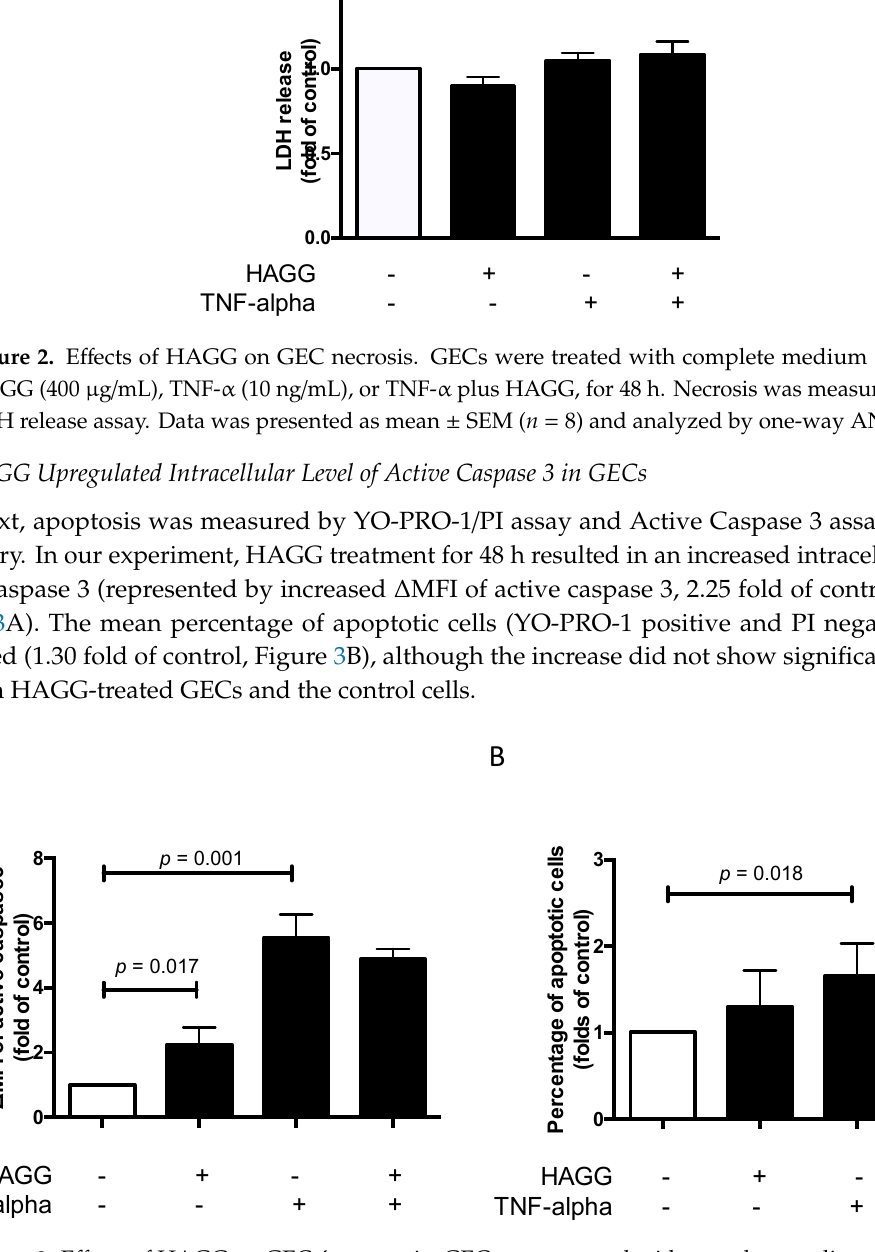
Figure 3. Effects of HAGG on GECs’ apoptosis. GECs were treated with complete medium (control), HAGG (400 µ g / mL), TNF- α (10 ng / mL), or TNF- α plus HAGG for 48 h. ( A ) ∆ MFI of active caspase 3 in GECs ( n = 4). ( B ) Percentages of apoptotic cells measured by YO-PRP-1 / PI assay ( n = 6). Comparisons between two groups were analyzed by paired t -tests.